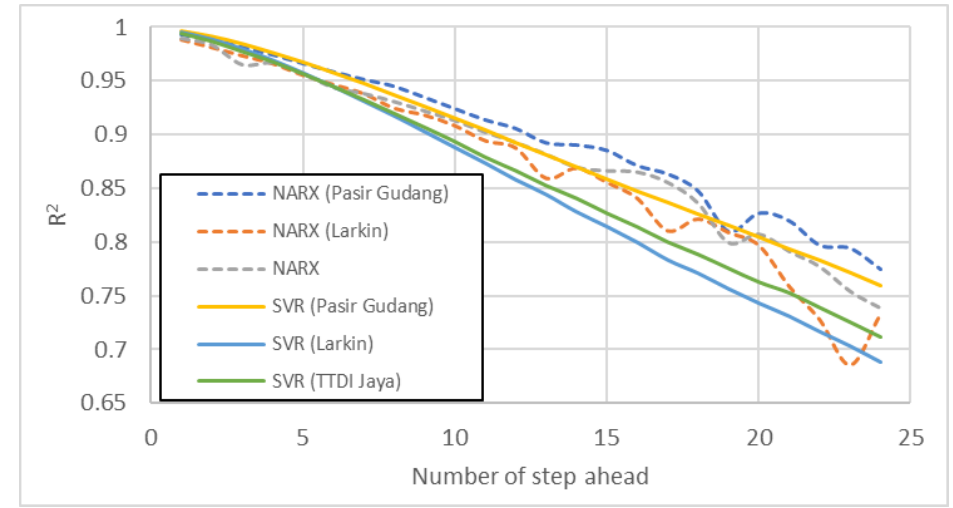
Figure 6. Multi-step prediction performance of NARX and SVR.